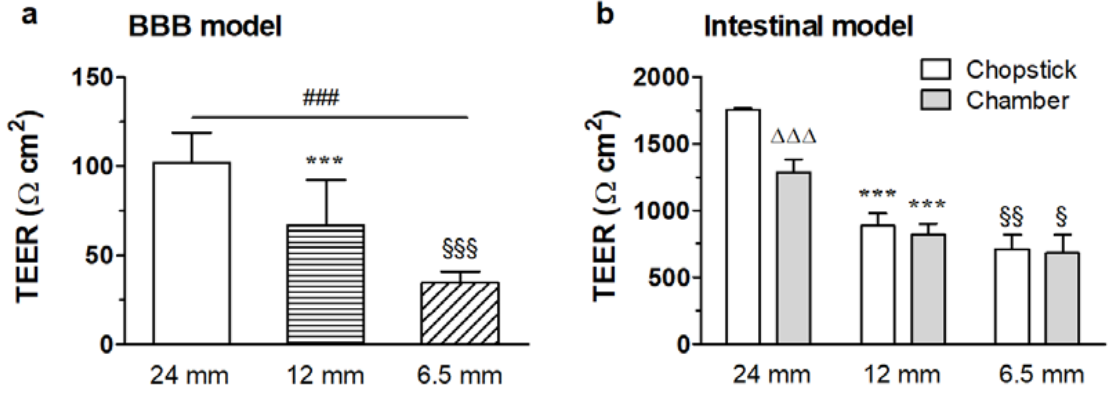
Figure 7. Effect of the cell culture insert circumference on the transendothelial electrical resistivity (TEER). ( a ) TEER measured with chopstick electrodes on immortalized mouse cerebellar capillary endothelial cells (cerebEND) using different sizes of cell culture inserts. Means ± SEM, n = 15–76, one-way ANOVA with Bonferroni post-test; ### p < 0.001, between 24 mm and 6.5 mm cell culture inserts; *** p < 0.001, between 24 mm and 12 mm cell culture inserts; §§§ p < 0.001, between 12 mm and 6.5 mm cell culture inserts. ( b ) TEER measured on an intestinal barrier model on different sizes of cell culture inserts both with the chopstick and the chamber electrode setup. Means ± SEM, n = 6, two-way ANOVA with Bonferroni post-test; ∆∆∆ p < 0.001, between chopstick and chamber electrodes; *** p < 0.001, between 24 mm and 12 mm cell culture inserts; § p < 0.05, §§ p < 0.01, between 12 mm and 6.5 mm cell culture inserts.